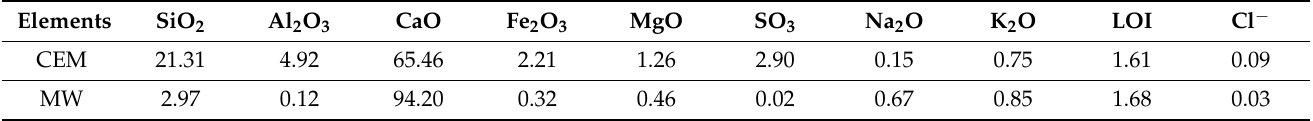
Table 2. XRF analysis of cement CEM I 42.5, and marble waste (MWS).